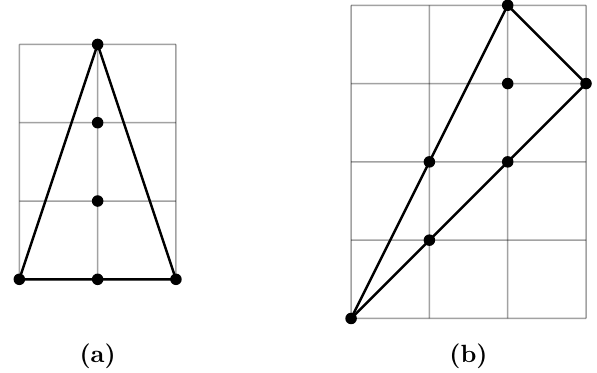
Figure 23. The toric diagrams for the C 3 / Z 6 orbifolds with actions: (a) (1,1,4) and (b) (1,2,3).